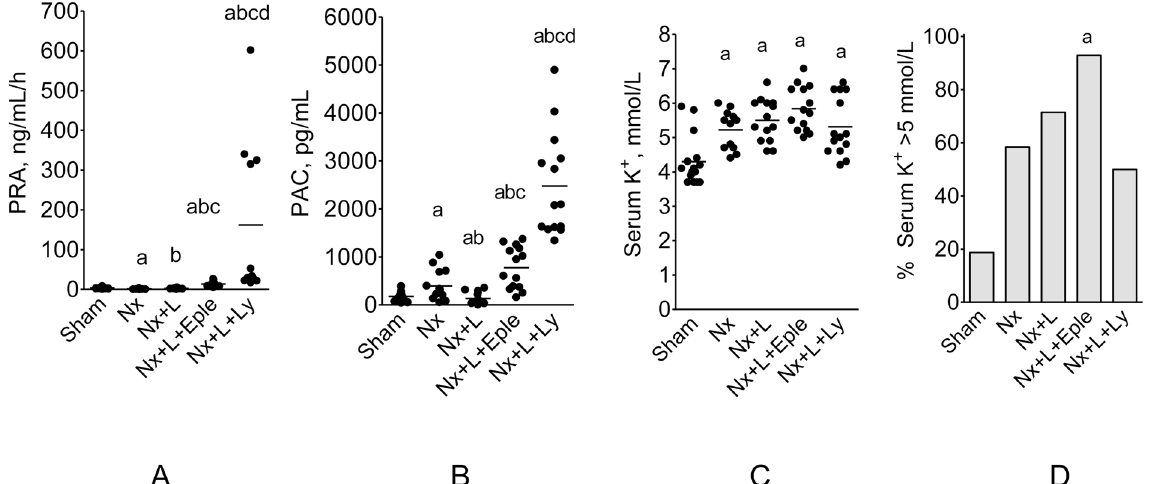
Figure 9. Plasma renin activity (PRA) ( A ), plasma aldosterone concentration (PAC) ( B ), serum K + ( C ) and percent hyperkalemia, defined as serum K + > 5 mmol/L ( D ) 150 days after renal ablation in Protocol 2. a p < 0.05 vs. Sham, b p < 0.05 vs. Nx, c p < 0.05 vs. Nx +